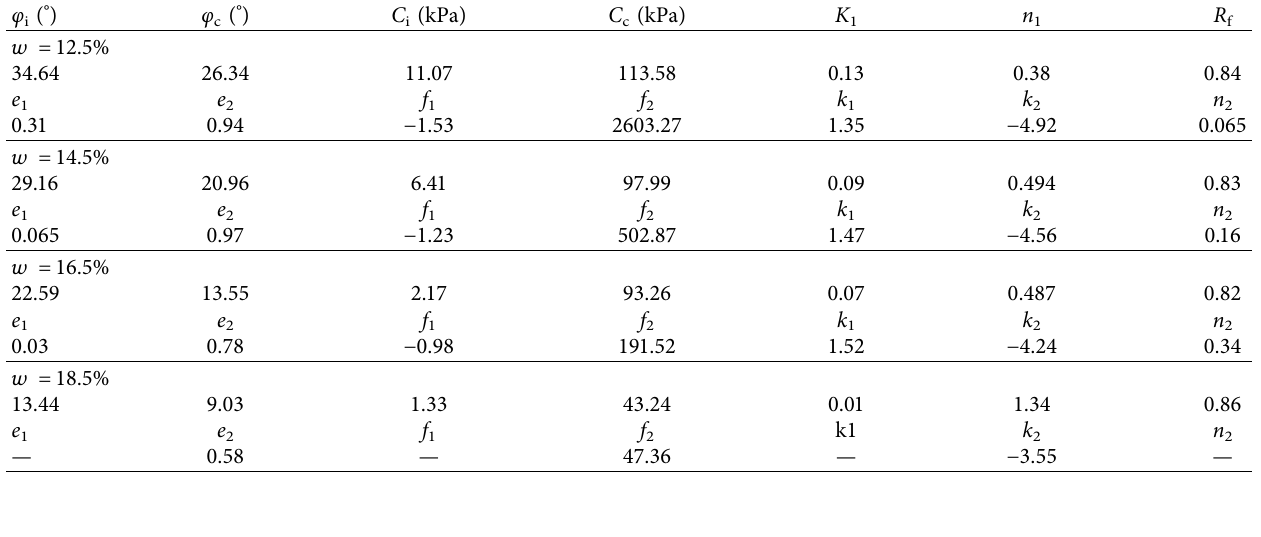
Figure 8: Pictures of failed samples. (a) Direct shear test of high plasticity clay-concrete interface. (b) Direct shear test of Table 3: Model parameters of interface tests.